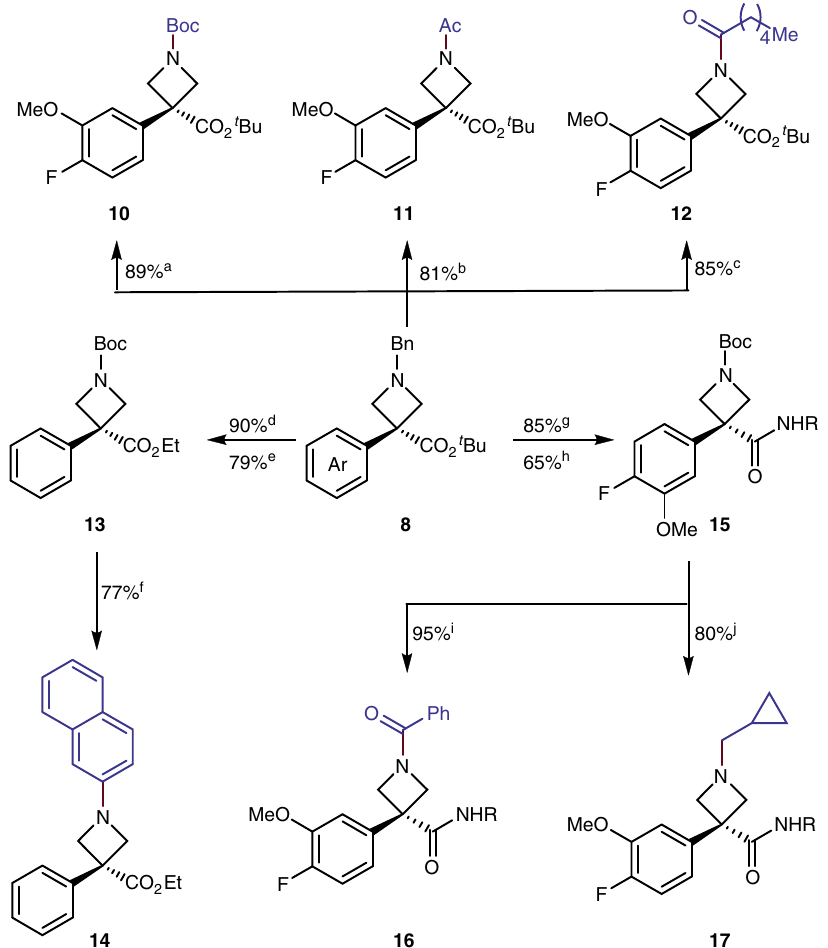
Fig. 5 Derivatizations of arylated azetidine products. a Pd(OH) 2 /C, Boc 2 O, MeOH, H 2 , RT. b Pd(OH) 2 /C, Ac 2 O, MeOH, H 2 , RT. c Pd(OH) 2 /C,